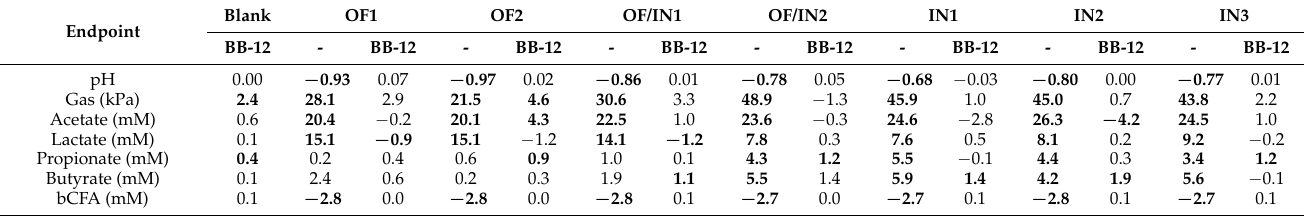
Table 2. Changes in metabolic activity upon dosing BB-12 and/or seven fructans with short (OF1, OF2), intermediate (OF/IN1, OF/IN2) and high degree of polymerization (IN1, IN2 and IN3) to the complex microbiota of three human donors (C, D and F). The values represent average differences over the three donors versus the respective reference (for fructans, the reference was the untreated blank, while for conditions with BB-12 addition this was the respective condition where BB-12 was not dosed). The data represent the average changes between 0–48 h (except for the intermediate metabolite lactate where it is the maximal value measured throughout the incubation). Significant changes are indicated in bold ( n = 9; 3 values for each of the 3 donors).